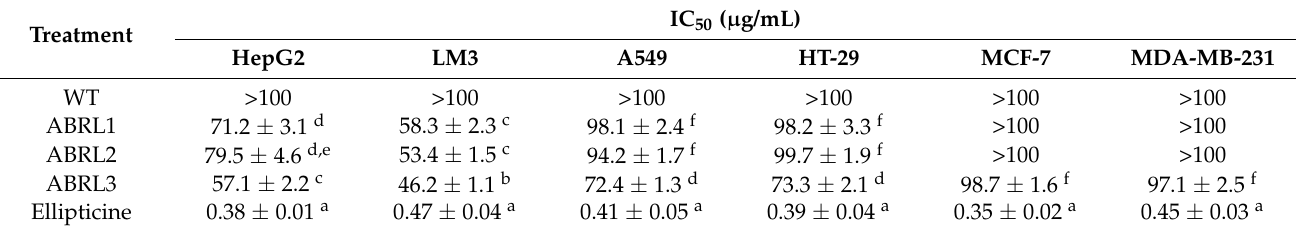
Table 5. IC 50 values of cell proliferation inhibition of Ajuga bracteosa extracts.